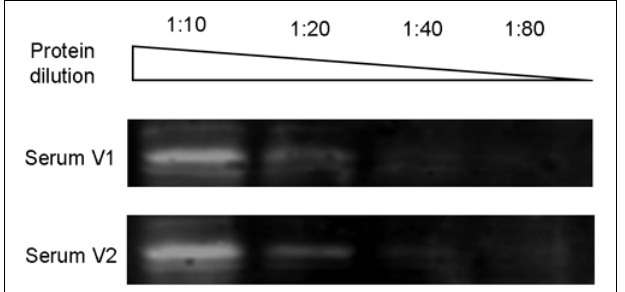
FIGURE 1 | No increase in antibody levels directed to γ -papillomavirus A2619. Visit 1 (V1) andVisit 2 (V2) sera were diluted 1:600 and incubated on Western blot containing a dilution series of L1